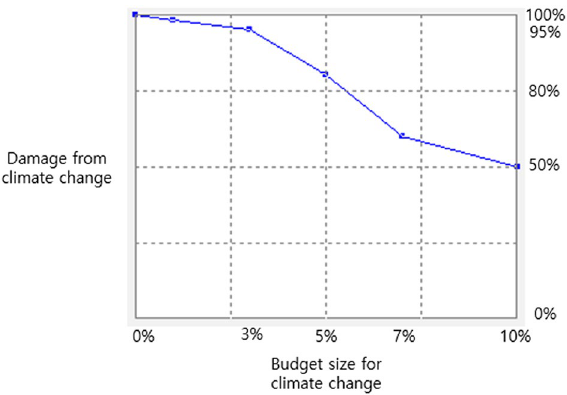
Figure 23. Effect of climate change budget size on climate change damage.